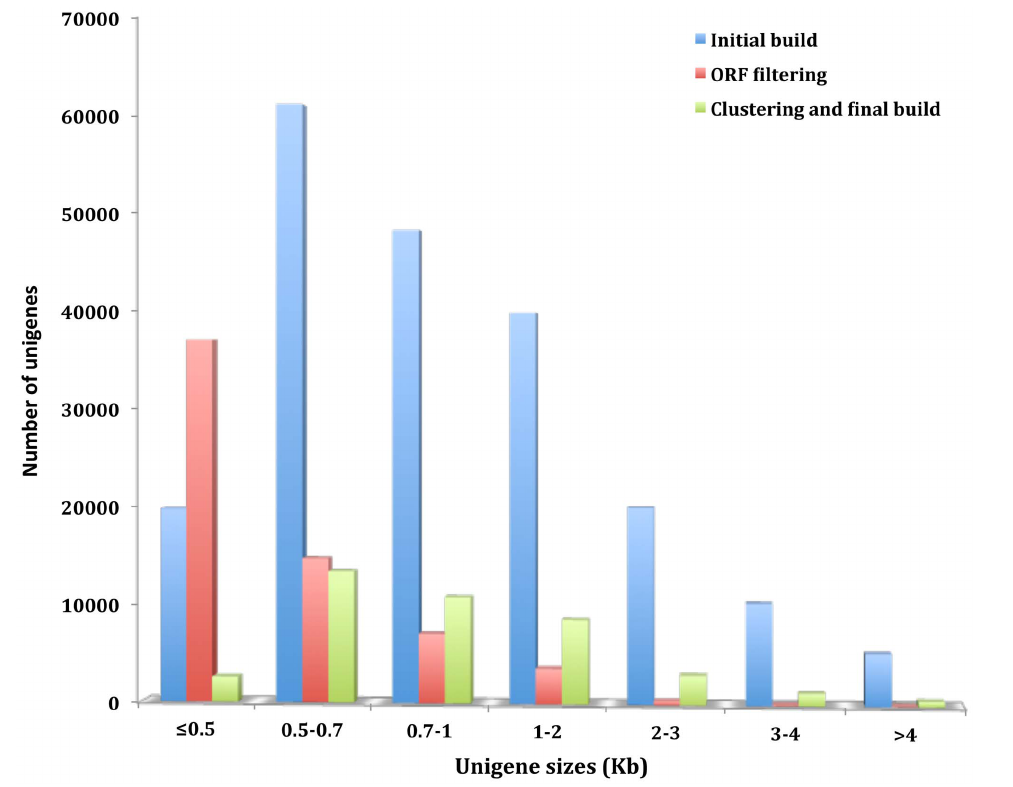
Figure 1. Culicoidessonorensis unigene assembly and filtering. Blue bars indicate the number of unigene sequences versus size that were present at the initial Trinity build. Red bars indicate the number and lengths of unigenes after ORF filtering, and green bars represent the final unigene build after clustering and manual inspection.